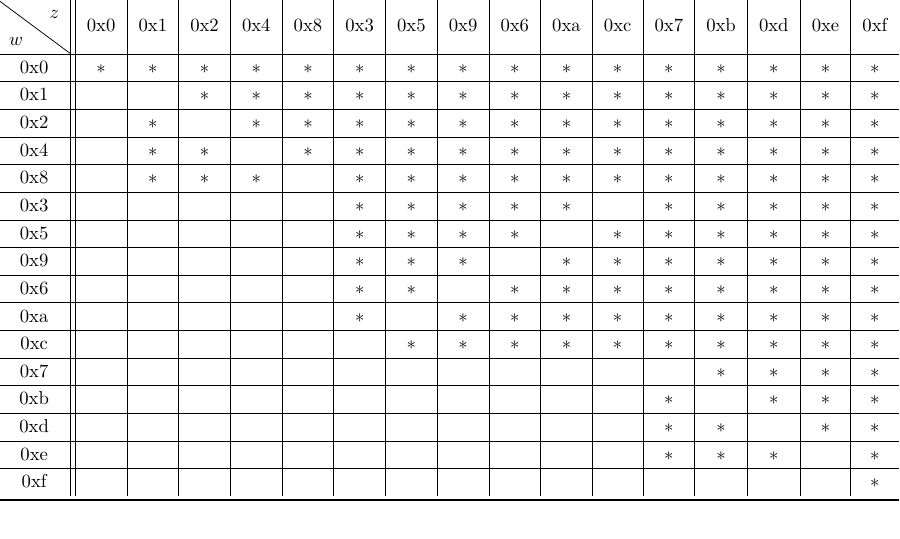
Table 16: The propagation of the division property for the binary